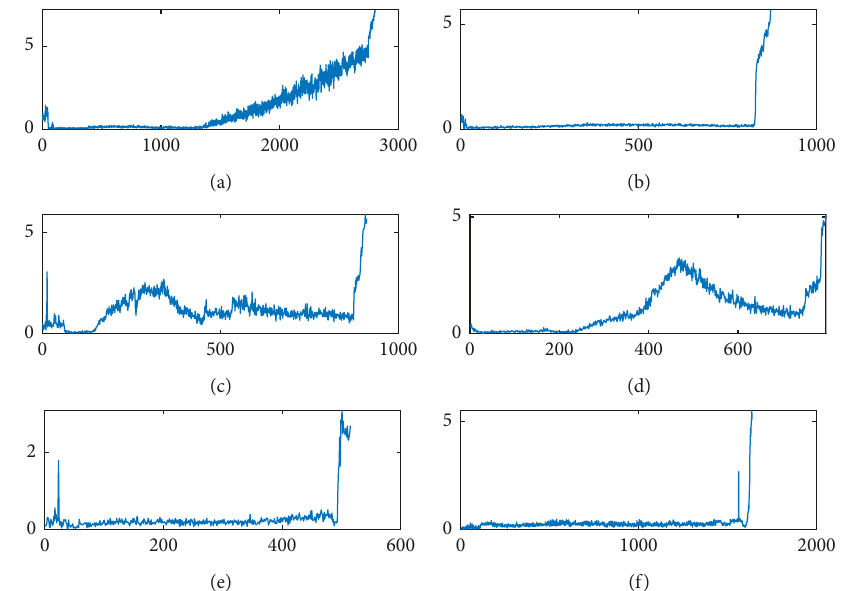
Figure 5: New form of Hilbert–Huang entropy. (a) Training set 1. (b) Training set 2. (c) Training set 3. (d) Training set 4. (e) Training set 5. (f) Training set 6.